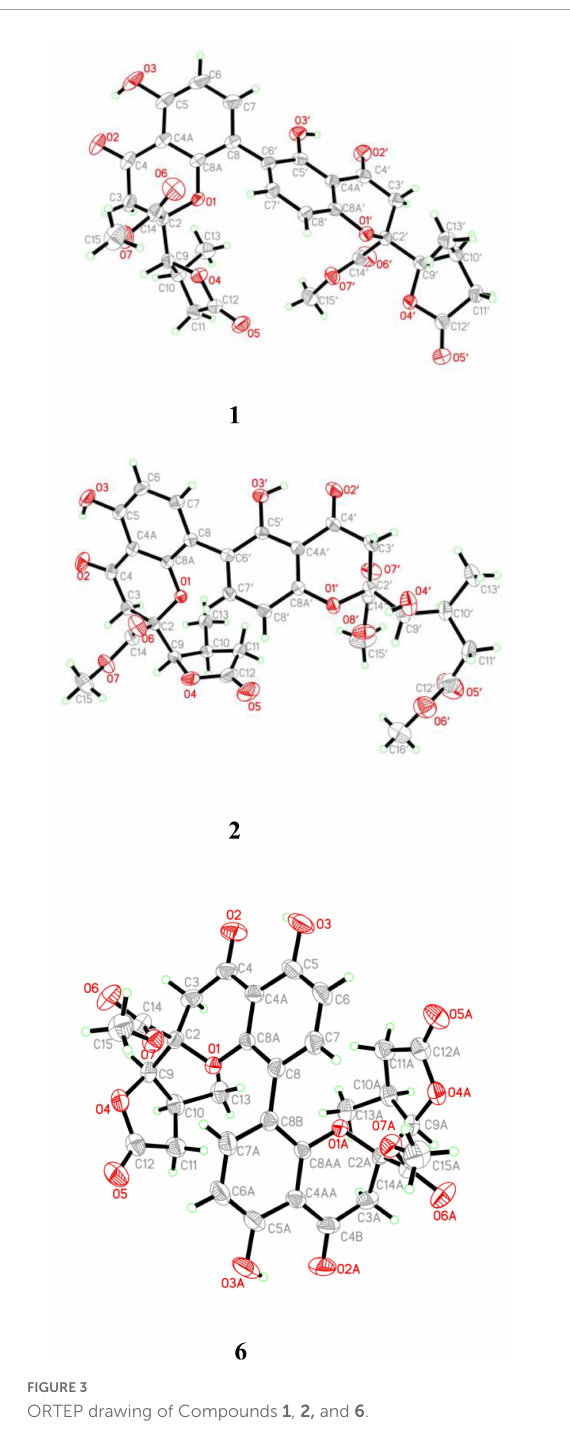
FIGURE3 ORTEP drawing of Compounds 1 , 2, and 6 .